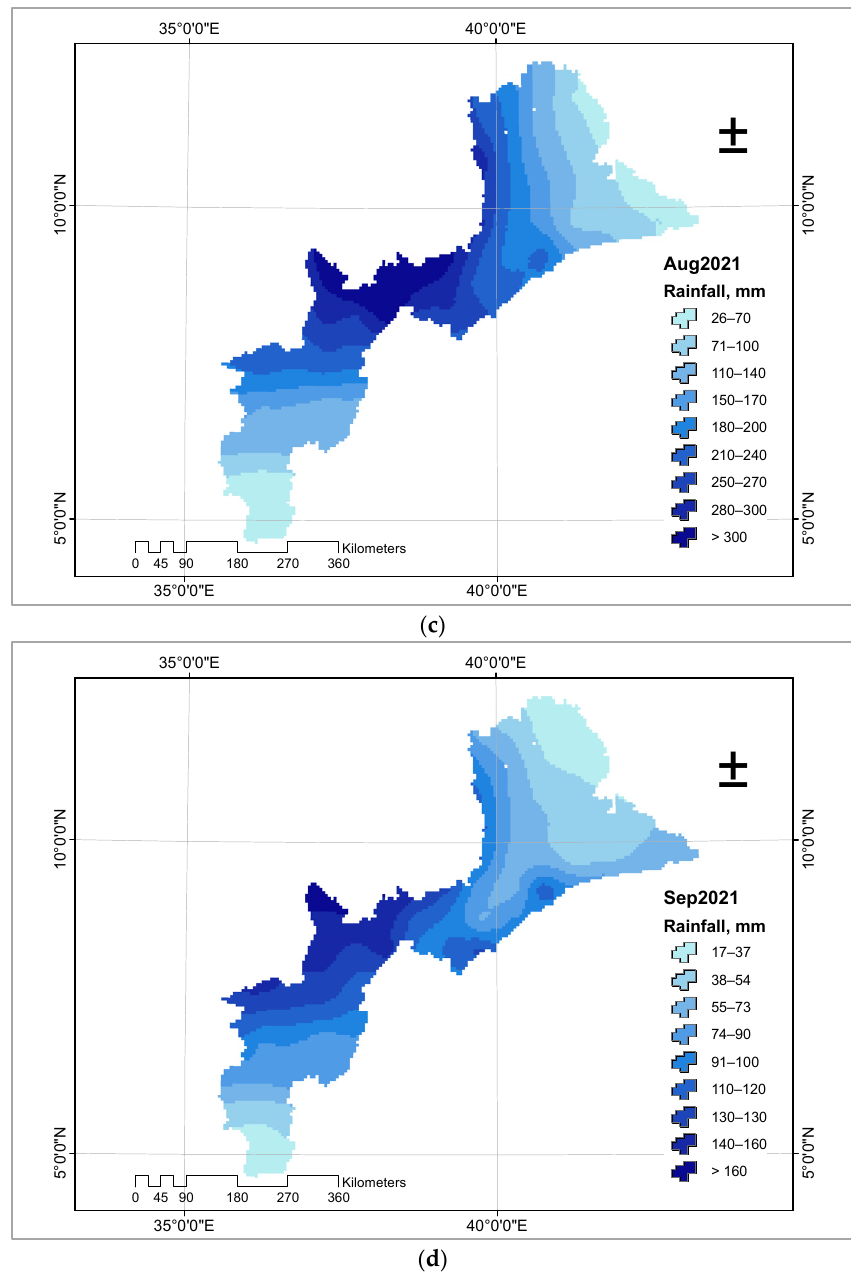
Figure 7. Spatial presentation of precipitation for the 2021 flood season. In essence, ( a ) the rainfall distribution for June, ( b ) the rainfall distribution for July, ( c ) the rainfall distribution for August, and ( d ) represents the rainfall distribution for the month of September.